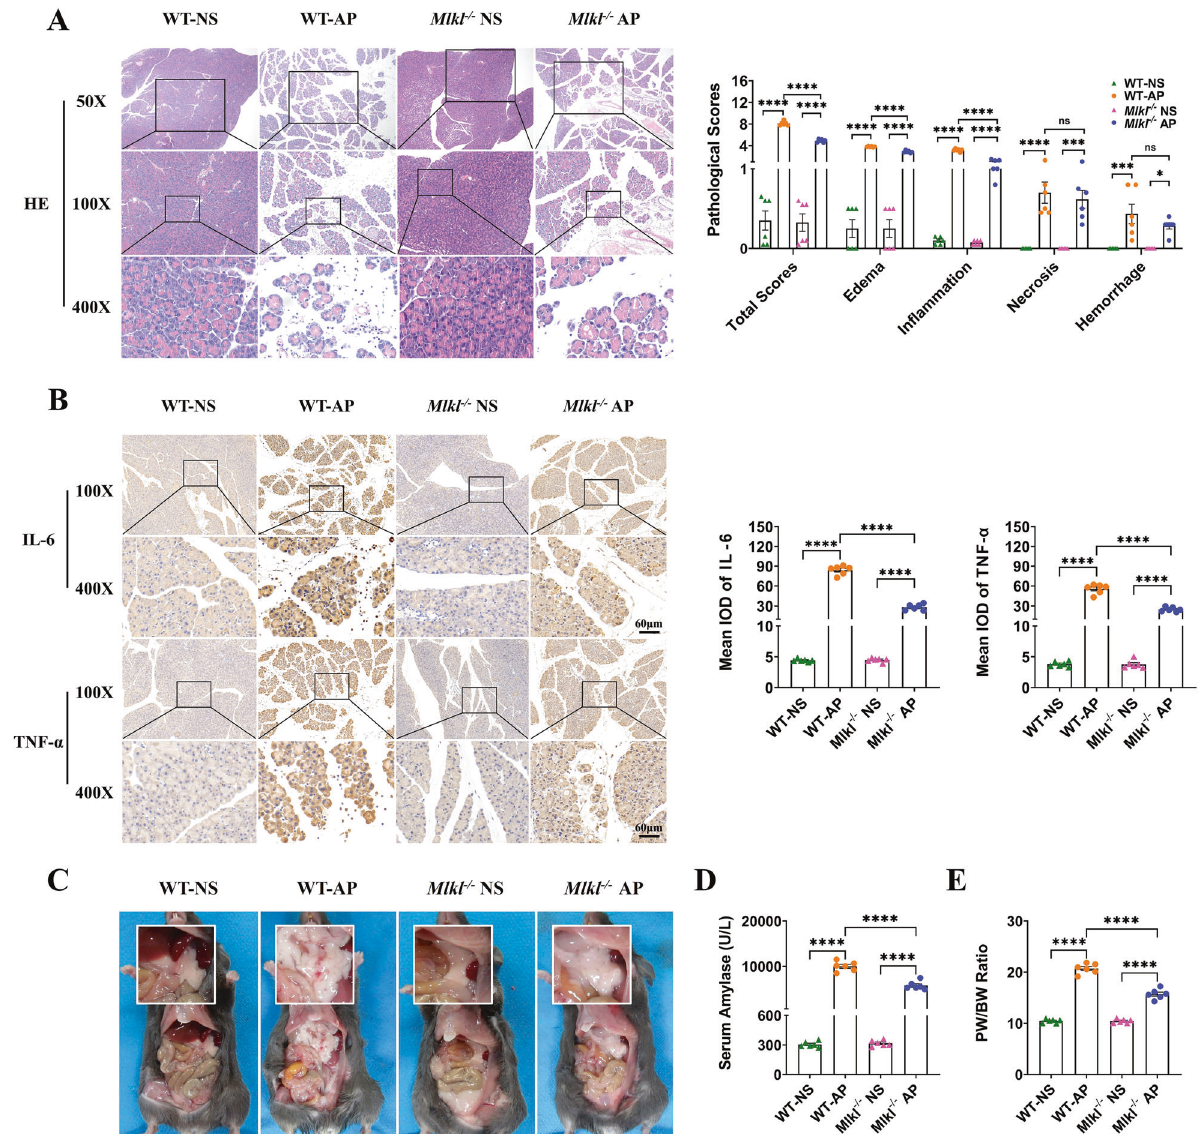
Fig. 2 Knockout of Mlkl reduced the severity of AP in mice, as indicated by decreased pancreatic pathological scores, expression of in fl ammatory mediators including IL-6 and TNF- α , extent of pancreatic edema, and level of serum amylase. A HE staining and pancreatic pathological scores of the pancreas ( n = 6). B Immunohistochemical staining of TNF- α and IL-6 in the pancreas ( n = 6). C Gross morphology of the pancreas ( n = 6). D Serum amylase ( n = 6). E The ratio of pancreas weight to body weight ( n = 6). Values are shown as the means ± SEMs. ns, not signi fi cant; * P < 0.05; ** P < 0.01; *** P < 0.001; **** P < 0.0001. WT wild type, IOD integrated optical density, NS normal saline, AP acute pancreatitis, PW pancreas weight, BW body